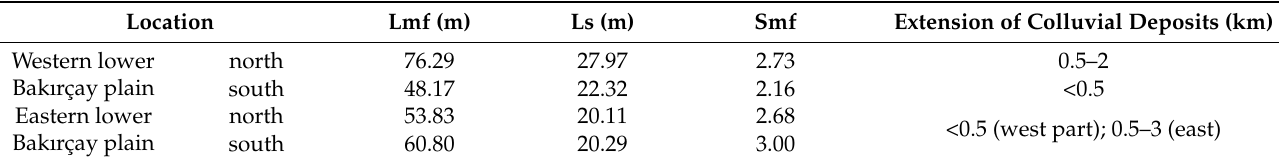
Table 3. Mountain-front sinuosity index (Smf) and extension of colluvial deposits in the lower Bakırçay plain. Location Lmf (m) Extension of Colluvial Deposits